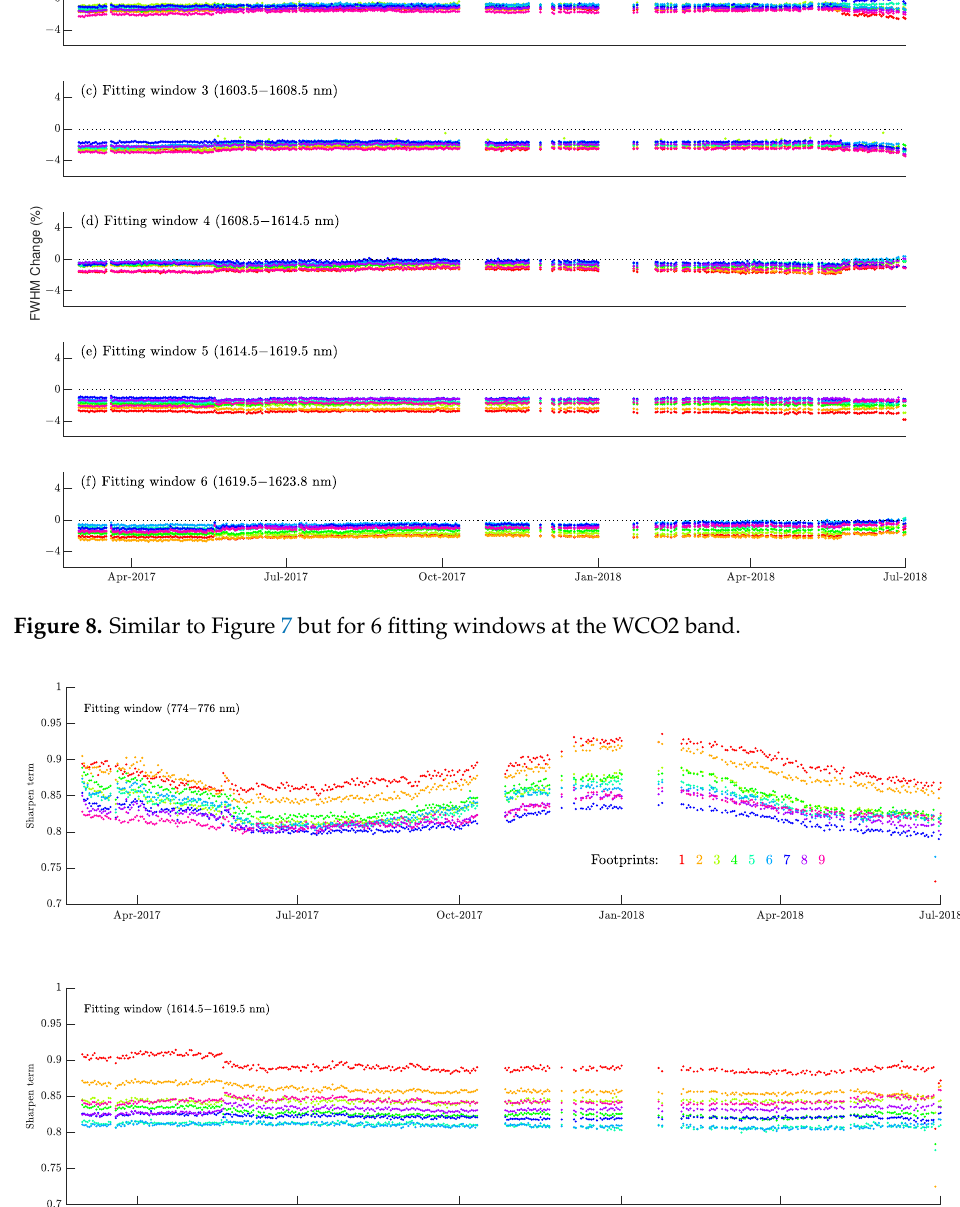
Figure 9. Sharpen term over time for window 6 in the O2A band and window 5 in the WCO2